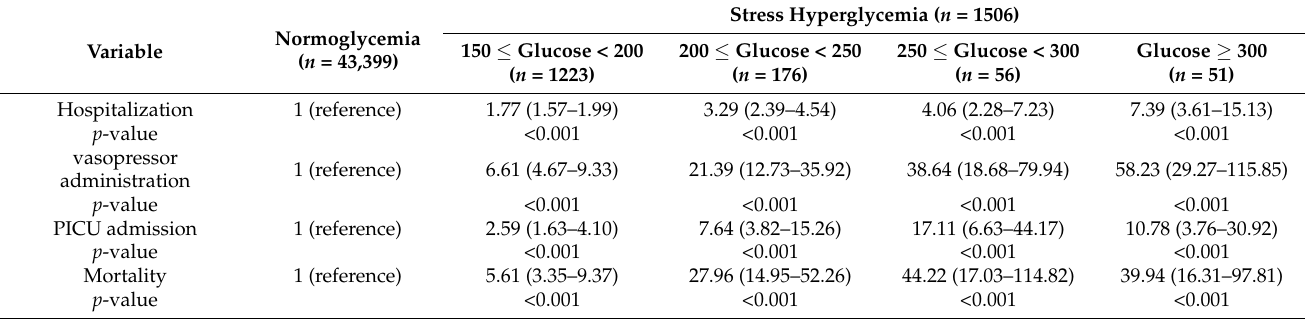
Table 3. Logistic regression analysis of patient outcomes with blood glucose levels ( n = 44,905).